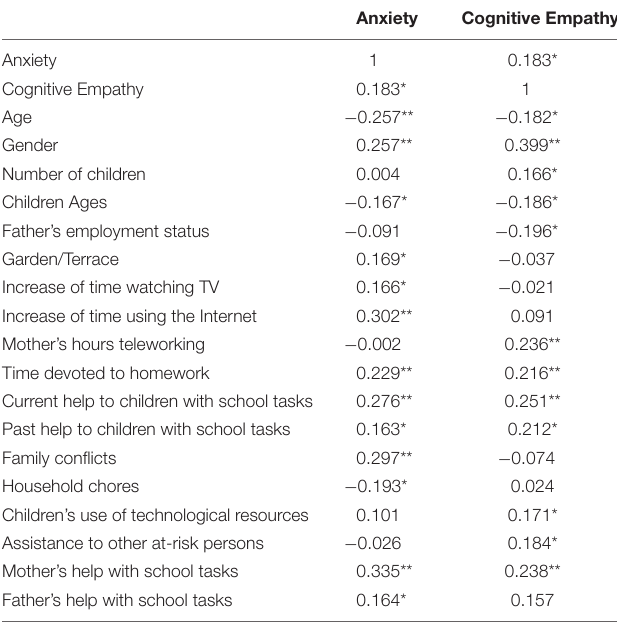
TABLE 1 | Significate correlations of sociocultural variables and anxiety and cognitive